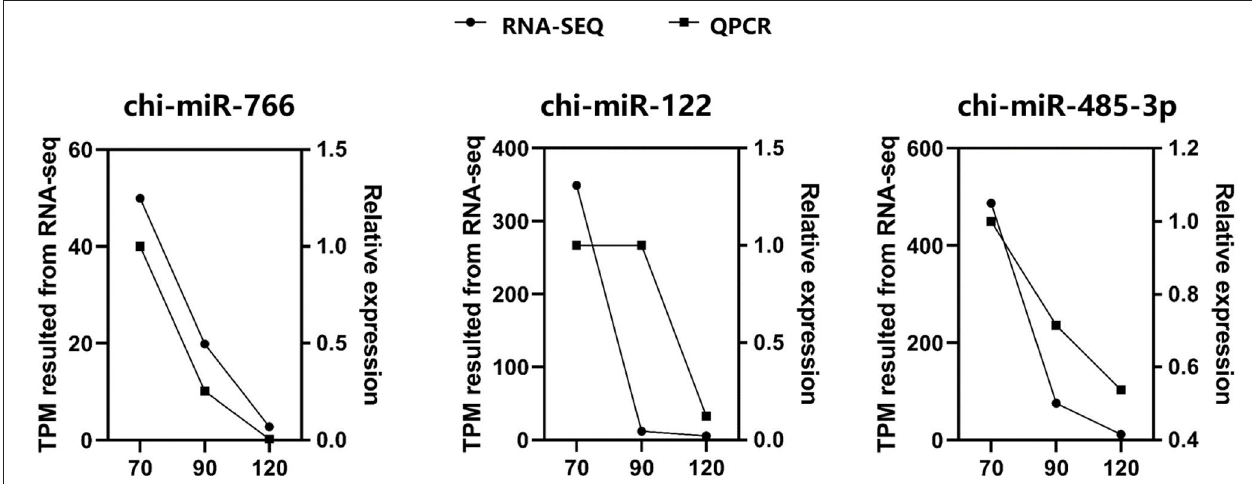
FIGURE 6 | The expression level of three miRNAs were validated by qRT-PCR and compared with the results of RNA-SEQ. For qRT-PCR data, miRNA expression was normalized to